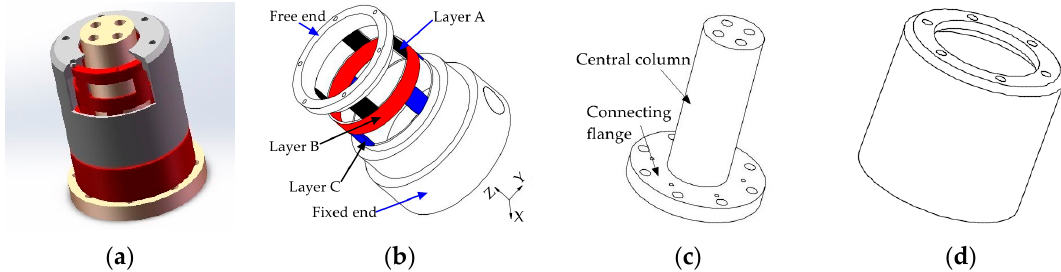
Figure 5. Schematic diagram of the composition of the cylindrical traction force sensor: ( a ) the basic architecture of the cylindrical traction force sensor; ( b ) cylinder-shaped elastic structural body; ( c ) connecting fitting; ( d ) shell.